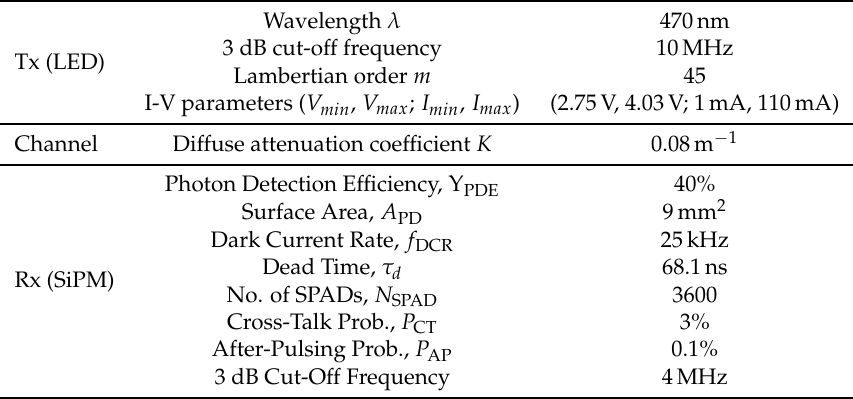
Table 1. Parameters of the Tx, channel, and the Hamamatsu C13366 3050GA SiPM. Wavelength λ 470nm 3 dB cut-off frequency 10MHz Tx (LED) Lambertian order m 45 I-V parameters ( V min , V max ; I min , I max ) (2.75V, 4.03V; 1mA, 110mA) Channel Diffuse attenuation coefficient K 0.08m − 1 Photon Detection Efficiency, Υ PDE 40% Surface Area, A PD 9mm 2 Dark Current Rate, f DCR 25kHz Dead Time, τ d 68.1ns Rx (SiPM) Cross-Talk Prob., P CT After-Pulsing Prob., P